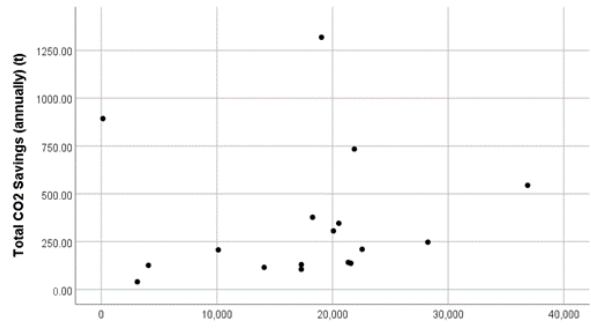
Figure 8. CO 2 savings per floor area (m 2 ). Table 8. Statistical data about the relationship between energy, water and CO 2 savings and floor